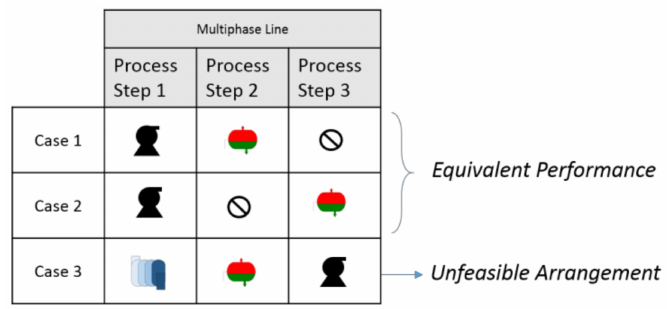
Figure 9. Case definition